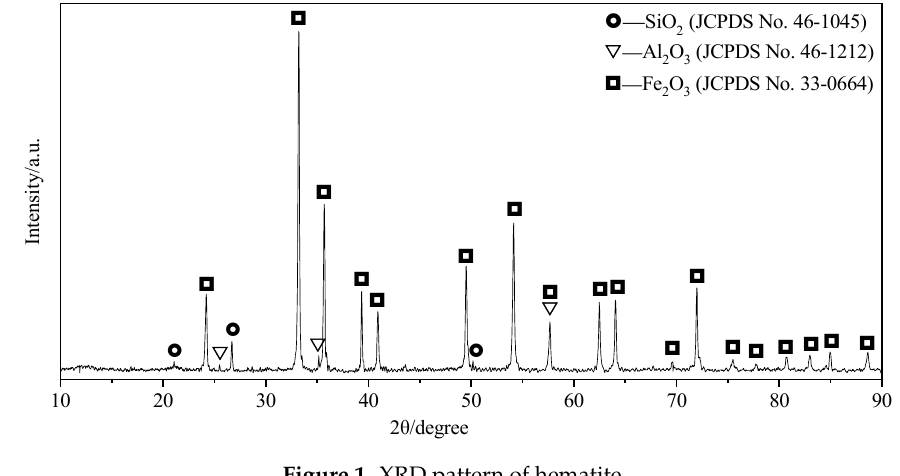
Figure 1. XRD pattern of hematite. Table 1. Chemical composition of the hematite powder